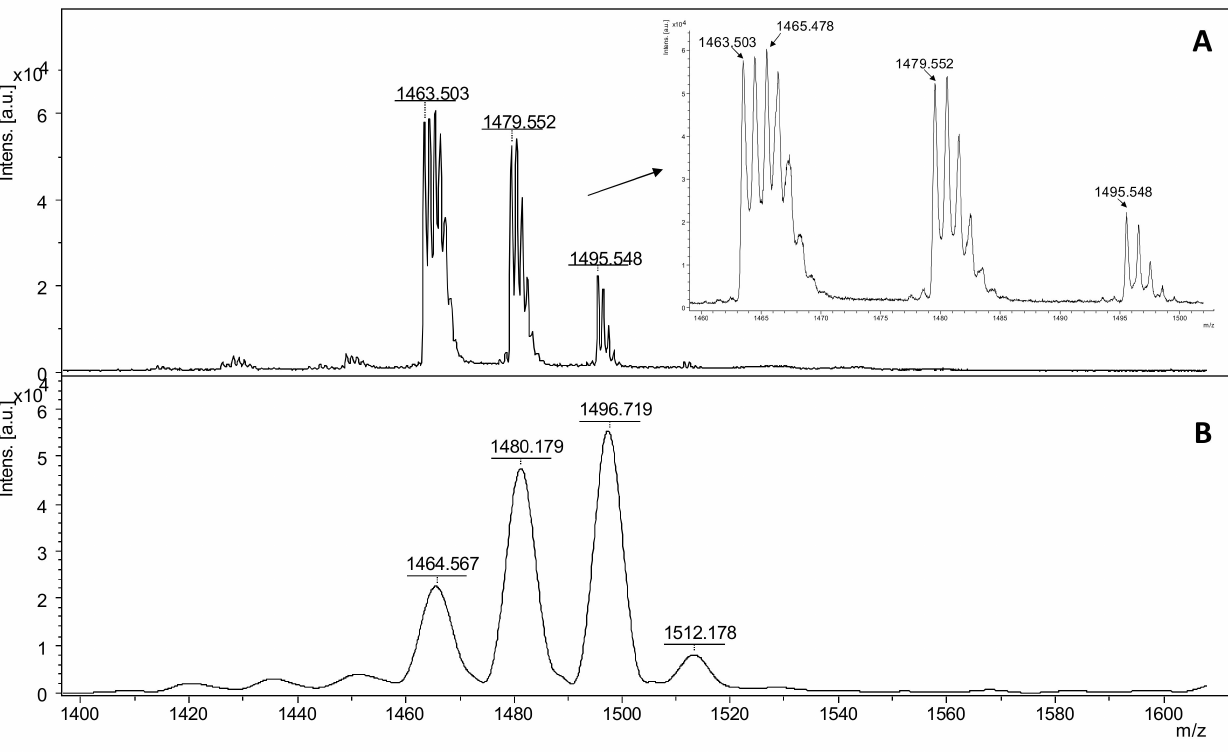
Figure 3. MALDI ToF mass spectra in reflectron ( A ) and linear ( B ) of intact ECP nitrated peptide with DHB as matrix where the NO 2 group of nitro tyrosine is photcehmical degraded due to UV laser radiation in MALDI ionization